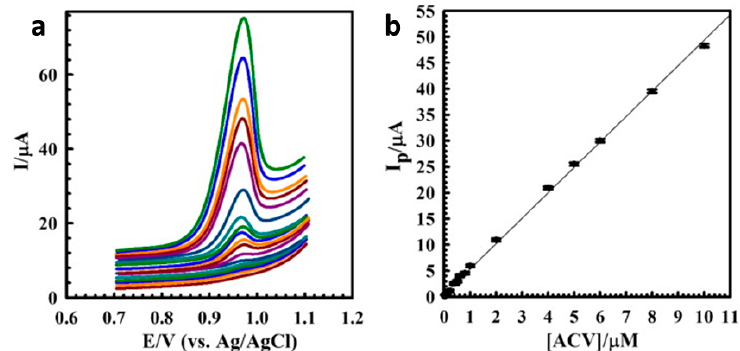
Figure 12. ( a ) Linear sweep voltammograms for various concentrations of ACV in the range of (bottom to top) 0.03–10.00 µM at 100 mV s − 1 in pH 7.0 phosphate buffer solution after 160